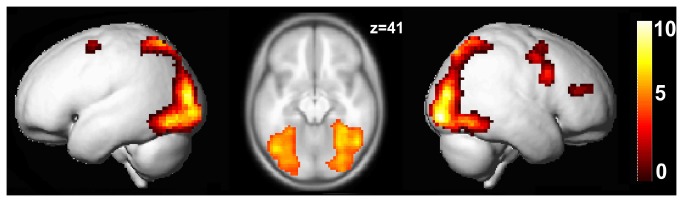
fMRI group activation at p < .05, FWE-corrected threshold for complex visual search vs. control and extent threshold k > 20.